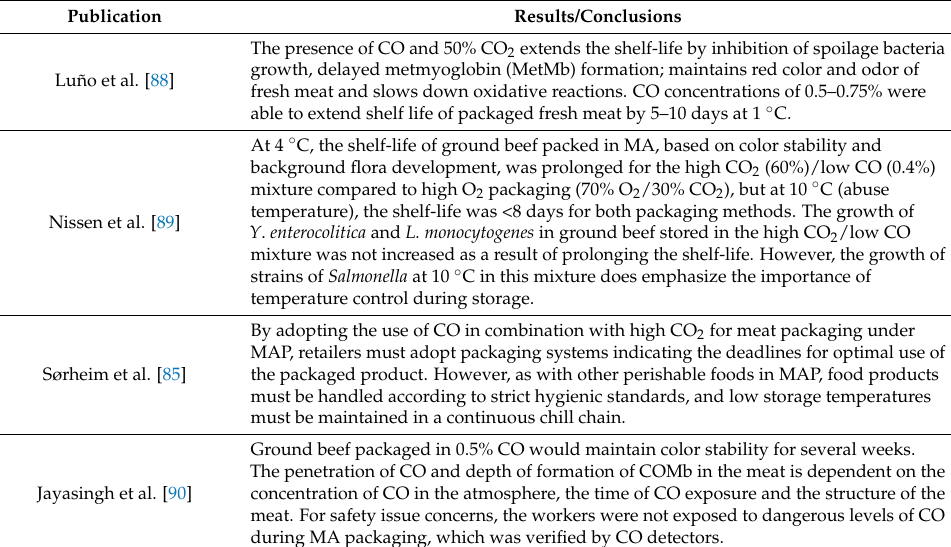
Table 1. Important findings in evaluating CO-modified atmosphere packaging (MAP) on extending the shelf-life of fresh